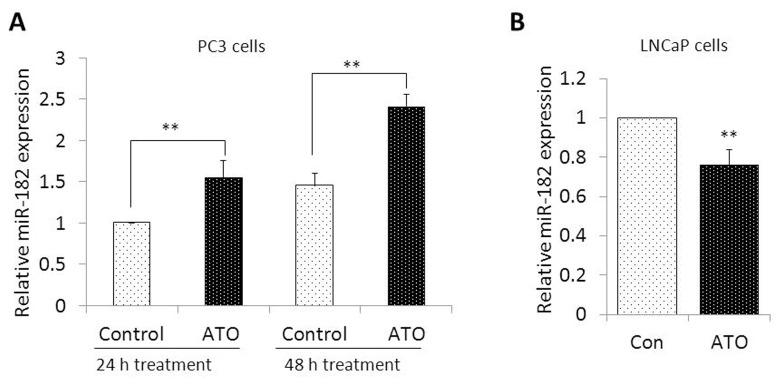
Effect of ATO on miR-182 expression in prostate cancer cells.(A) PC3 cells were exposed to 5 µM ATO for 24 h and 48 h. Total RNA was isolated and subjected to Taqman qRT-PCR analysis using primer sets for miR-182. (B) LNCaP cells were exposed to 5 µM ATO for 48 h, followed by analysis of miR-182 expression. Data are summarized from 3 independent experiments and expressed as Mean ± SD. **p<0.01.